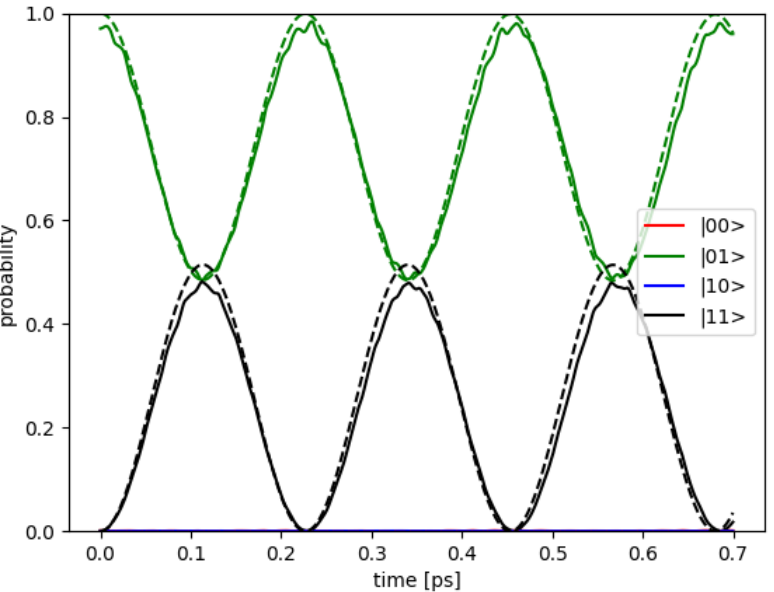
Figure 10. The dynamics of states of two DQDs with the inter-DQD Coulomb interaction for the initial state | 01 (cid:105) , the QD base length b = 2.0 nm, the inter-QD distance d = 3.0 nm and the two DQDs are separated with the inter-DQD distance a = 8.0 nm. The solid and dash lines are electronic potential and matrix models,